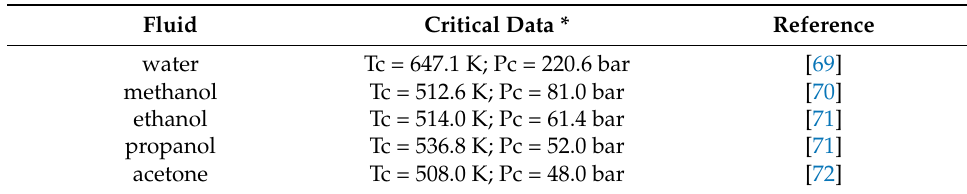
Table 1. Most used sub- and supercritical fluids as a solvent in carbon fiber-reinforced composite recycling.